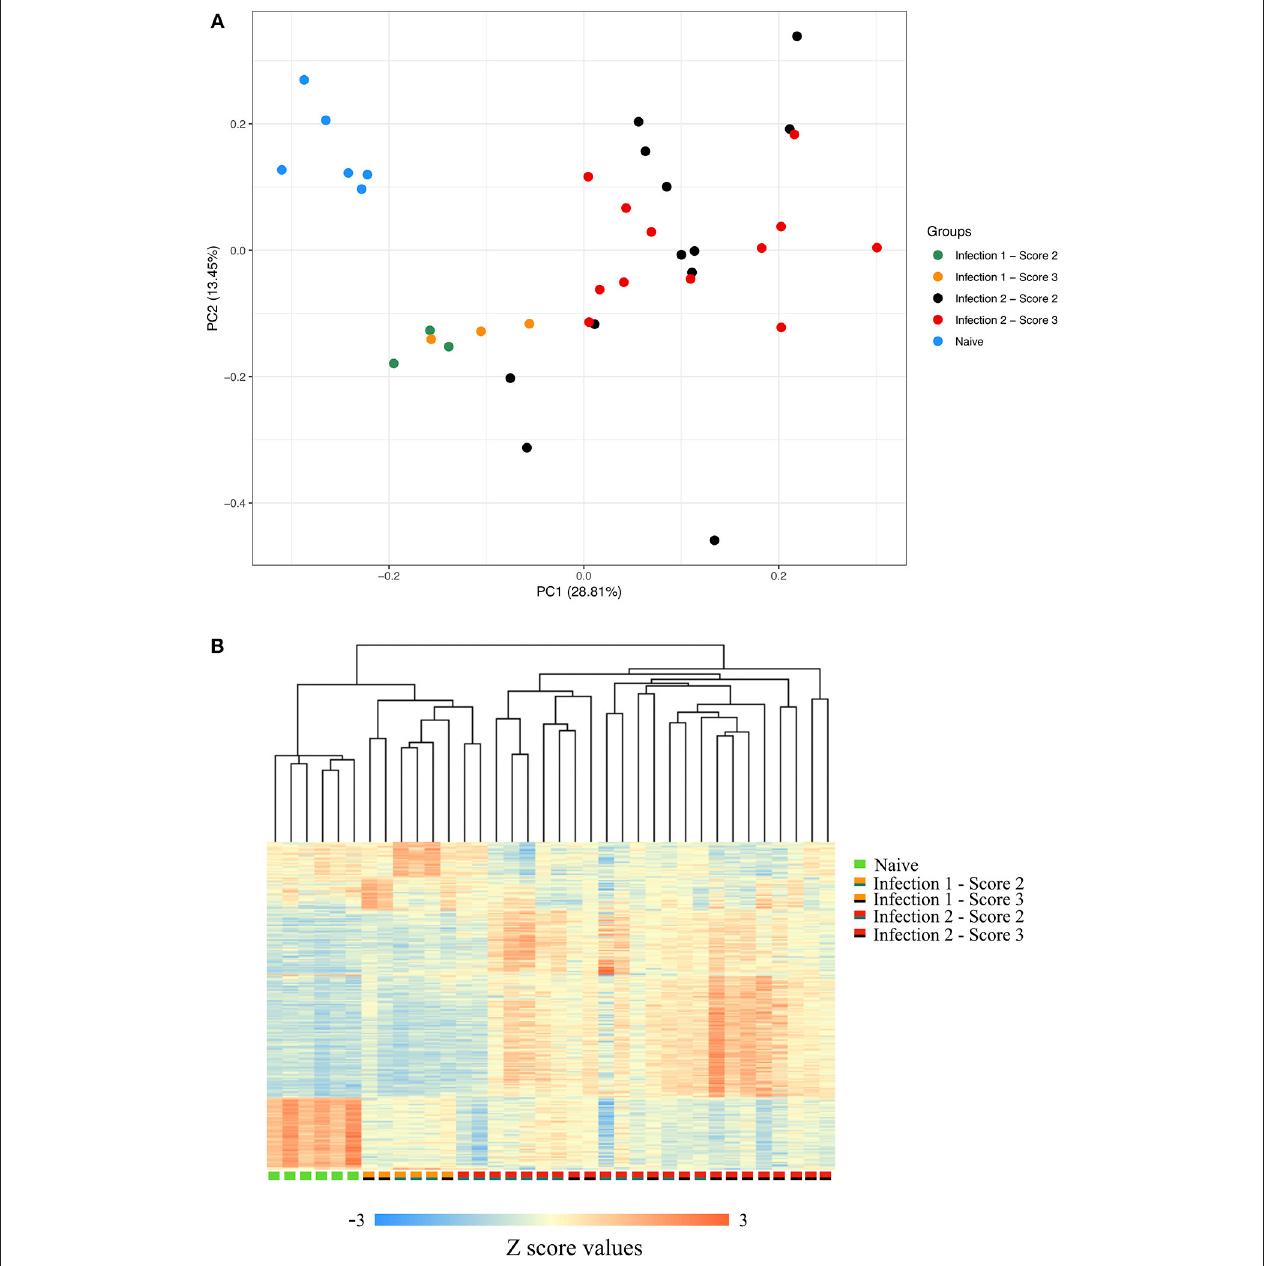
FIGURE 1 | (A) Principle component of gene expression. (B) Clustering of the gene expression data between the naïve, animals during the first infection with scores 2 or 3 and animals during the second infection with scores 2 or 3. The scorings are based on the scheme outlined by Taylor et al.